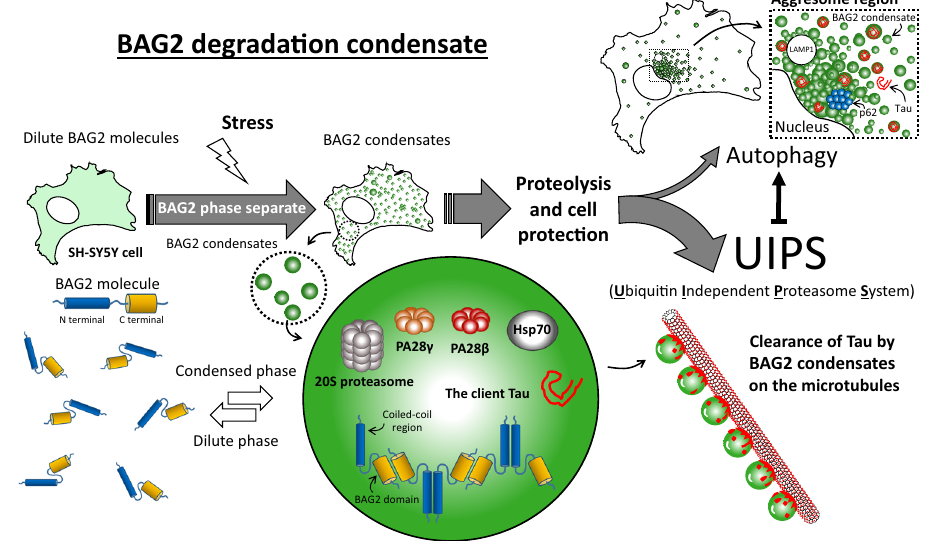
Fig. 8 Schematic representation of the BAG2 degradation condensate. BAG2 marks a distinct phase-separated membraneless organelle, triggered by several forms of stress, particularly hyper-osmotic stress. BAG2 condensation depends on both the amino terminal coiled-coil domain and the carboxy terminal BAG2 domain. Distinct from well-known condensates such as stress granules and processing bodies, BAG2-containing granules lack RNA, lack ubiquitin and promote client degradation in a ubiquitin-independent manner via the 20S proteasome (UIPS). Components of these condensates include the chaperone HSP-70 and the 20S proteasome activated by members of the PA28 (PMSE) family. These organelles protect the viability of cells from stress and are capable of traf fi cking directly to their clients, in the case of Tau, on the microtubule. BAG2 condensates did not co-localize with LAMP-1 or p62- SQSTM1. When the proteasome is inhibited, BAG2 condensates can traf fi c to an aggresome-like structure with the autophagy markers LAMP-1 and p62/ SQSTM1. LAMP-1 signal is predominantly in regions devoid of BAG2 and p62/SQSTM1 antibody labels a discrete region in proximity to the BAG2 signal. This observation suggested that within the aggresome-like structure, clients were possibly segregated according to their mechanism of protein